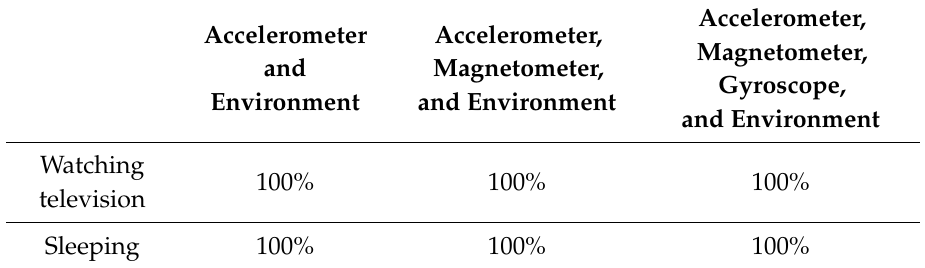
Table 17. Accuracies of the activities’ recognition without motion using the AdaBoost with the decision tree implemented with the SMILE framework for motion and magnetic sensors after the recognition of the environment.